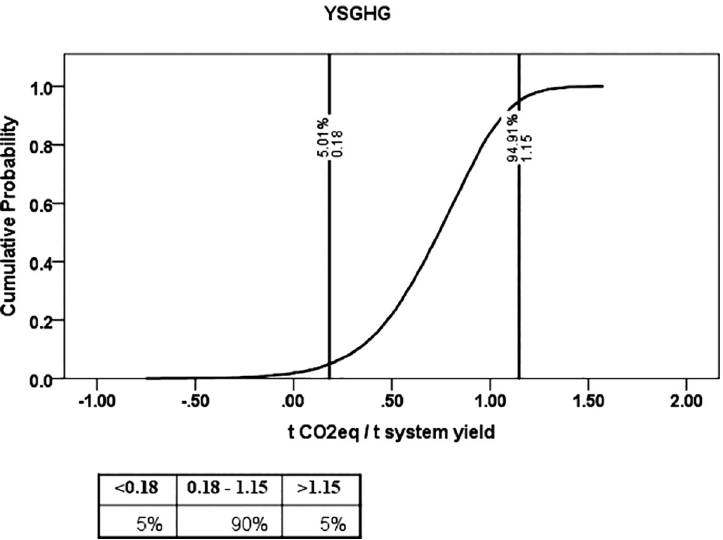
Fig 11. Cumulative Density Function (CDF) of yield-scaled GHG emission (YSGHG) in the study